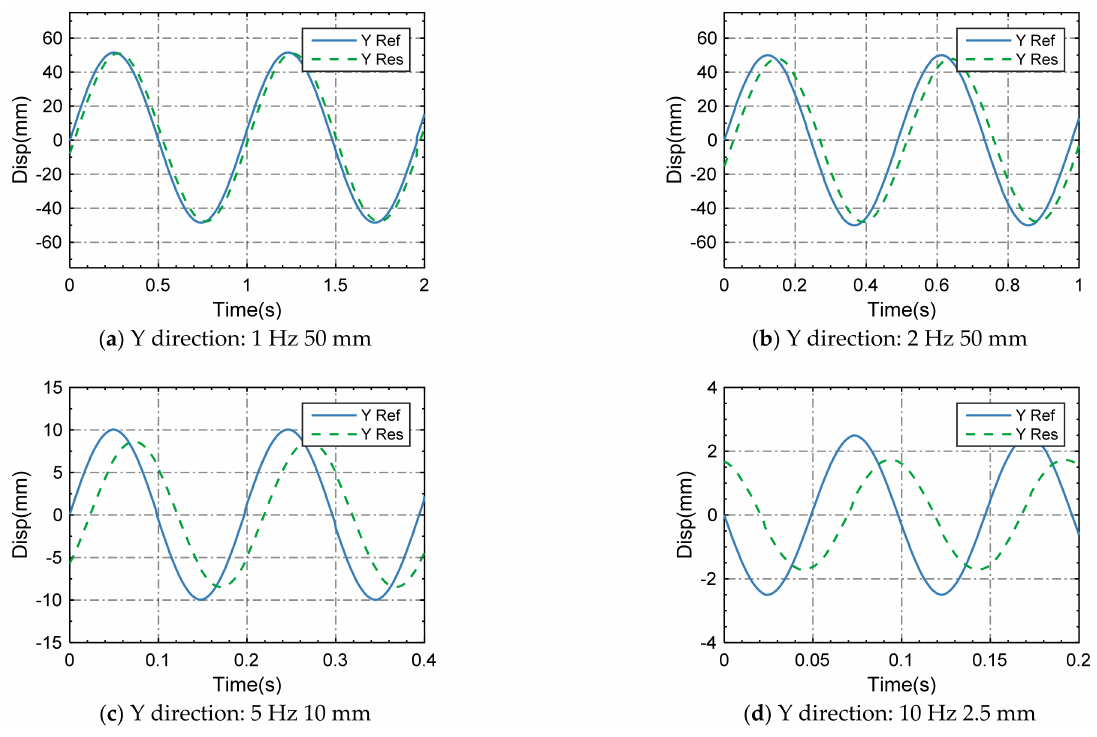
Figure 9. Experiment Result of Sinusoidal along Y